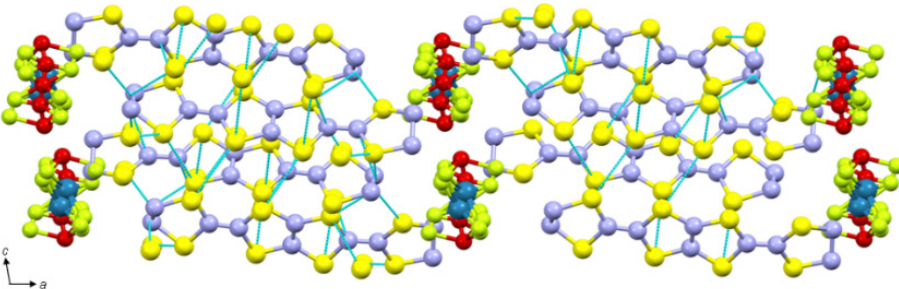
Figure 3. Crystal structure of the κ -(BDH-TTP) 4 ReF 6 · 4.8H 2 O ( 2 ) salt projected on the ac -plane. Dashed lines show shortened intermolecular contacts between the BDH-TTP molecules.